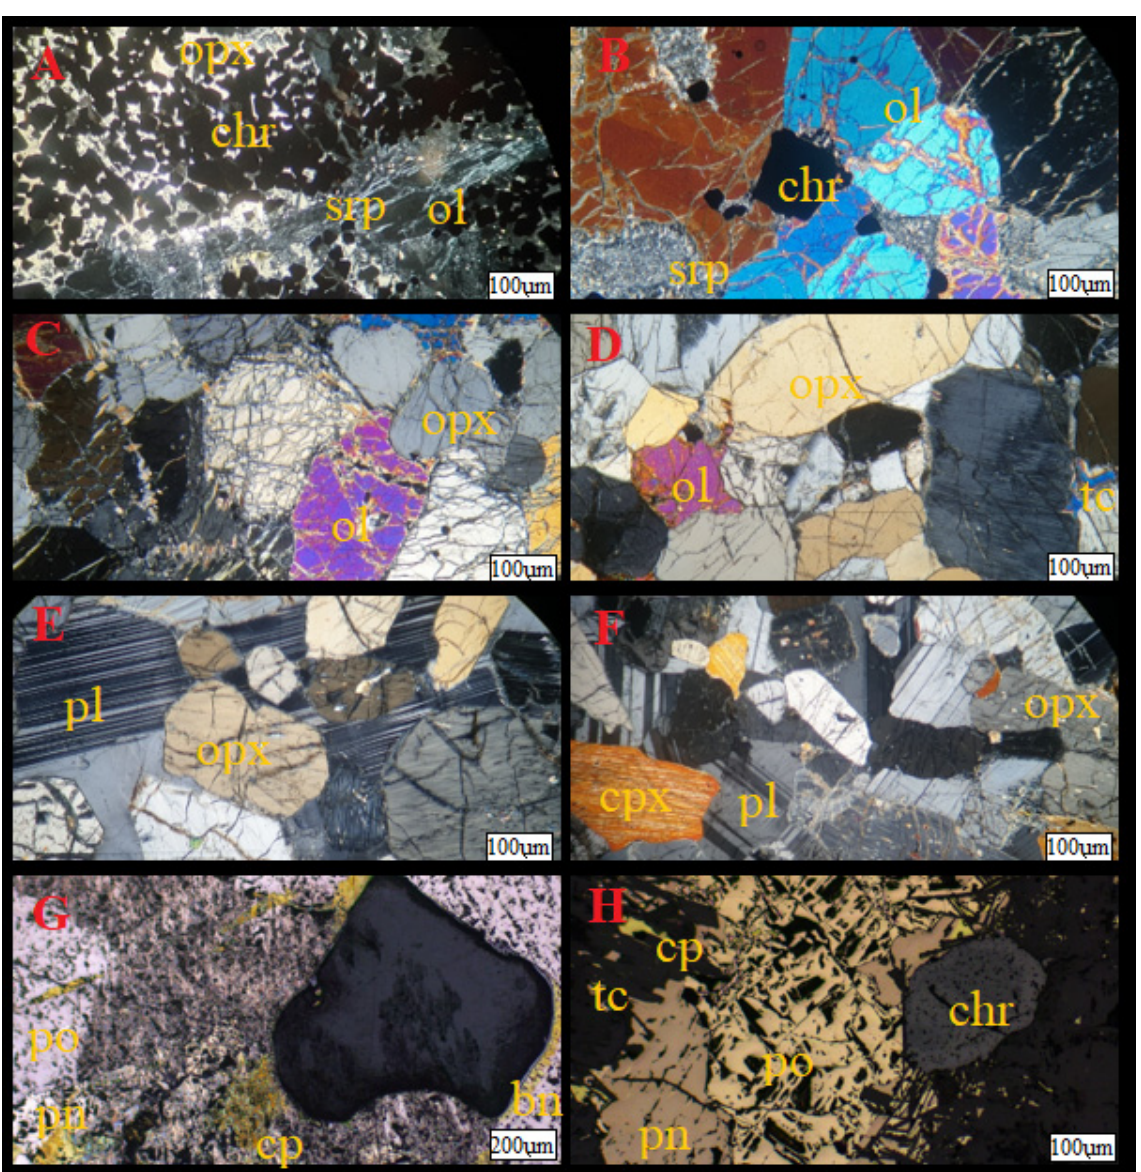
Figure 3. Microphotograph of the selected rocks types (( A – F ) polarizing microscope, ( G , H ) reflected light): ( A )—chromitite with chromite (chr) crystals on the orthopyroxene (opx) and serpentinized (srp) olivines (ol); ( B )—dunites with zonal olivines and chromites and serpentine; ( C )—harzburgites with orthopyroxene and olivine; ( D )—orthopyroxenites with talc (tc); ( E )—norites with orthopyroxenes and plagioclases (pl); ( F )—gabbronorites with ortho- and clinopyroxenes (cpx) with plagioclases; ( G , H ) sulfide ores with pentlandite (pn), pyrrhotite (po), chalcopyrite (cp), and sometimes with bornite (bn) accompanied by crystals of talc and zonal chromite.